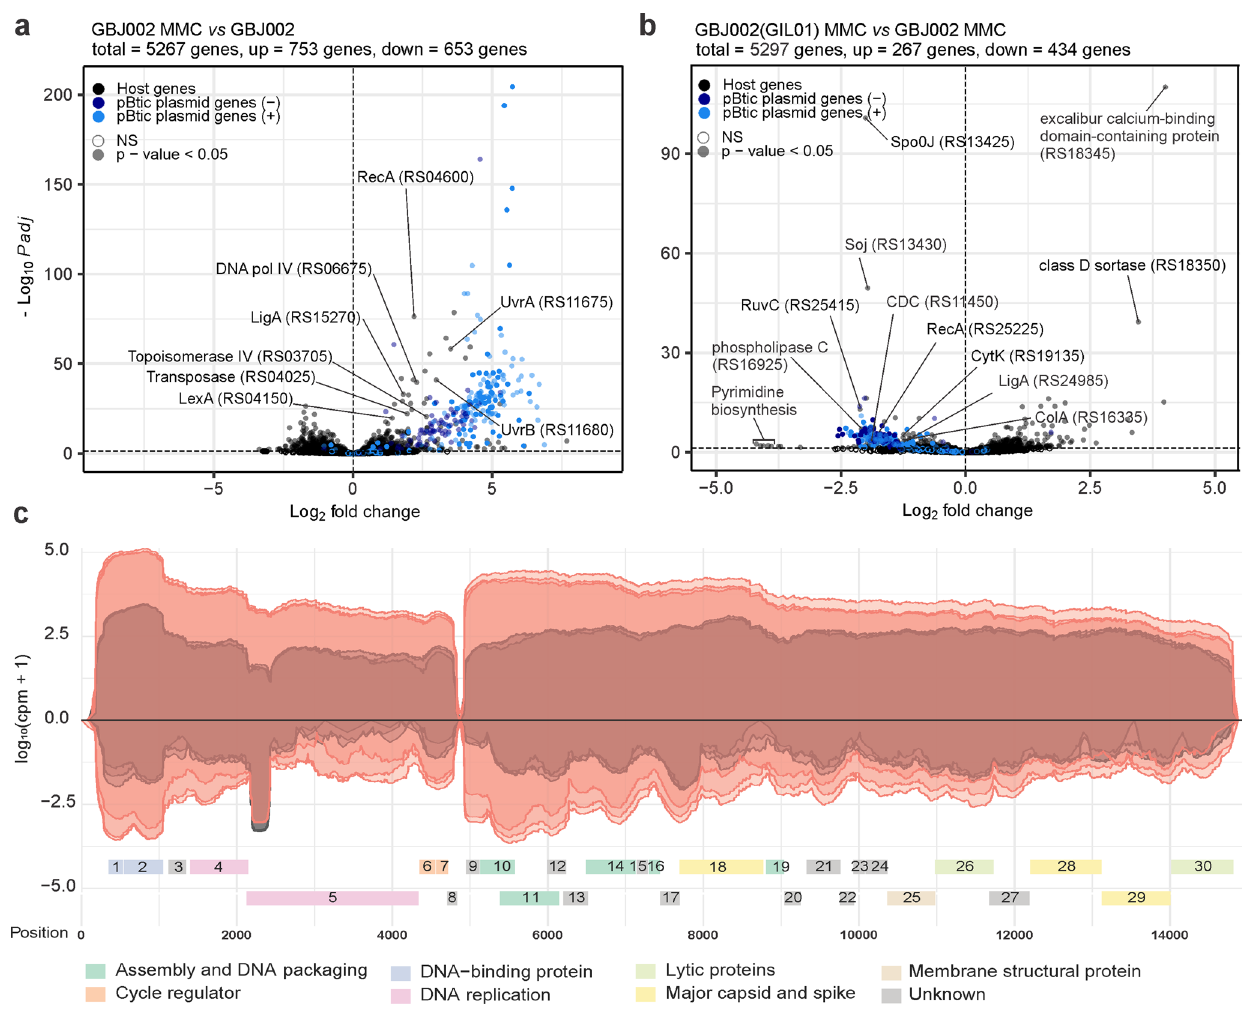
Fig. 1 Bacillus thuringiensis response to mitomycin C (MMC) treatment and prophage GIL01 induction. Volcano plots showing gene-expression changes between: a MMC-treated (100 ng mL − 1 , 30 min) and untreated GBJ002 cultures; b MMC-treated (100 ng mL − 1 , 30 min) GBJ002(GIL01) and GBJ002 cultures. The pBtic235 genes encoded on the sense ( + , plasmid module) and anti-sense ( − , phage module) strands, and the host genes are shown in the indicated colors. A signi fi cance cut-off of a FDR-adjusted p -value (Padj) of ≤ 0.01 was used. Genes without statistically signi fi cant fold-changes are indicated as NS. CDC, cholesterol-dependent anthrolysin O/cereolysin O family member protein and ColA, collagenase. Experiments were performed in three biological replicates. c GIL01 transcriptome in strain GBJ002(GIL01) 30 min after MMC treatment. The graph represents the GIL01 genome (ORF1- ORF30) with normalized read coverage for three biological replicates treated with MMC (100 ng mL − 1 ) (read coverage in red) compared to their respective untreated samples (read coverage in gray). Reads are represented on a logarithmic scale (log 10 counts per million). Gene features are colored based on putative or known gene functions 15 . Experiments were performed in three biological